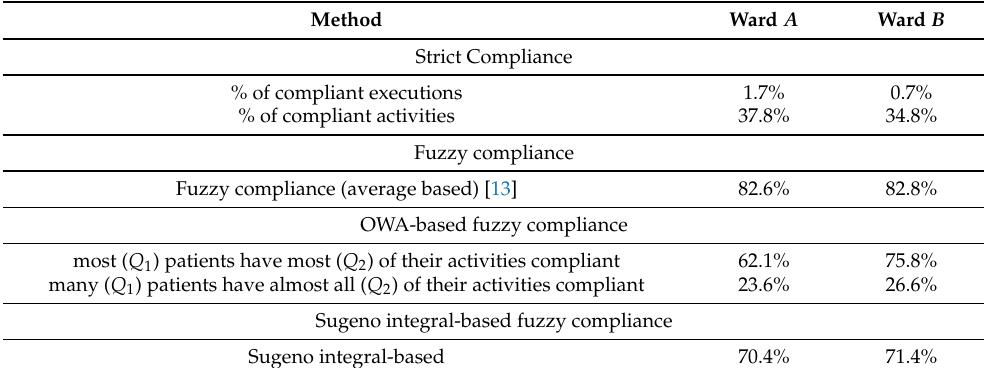
Table 4. Compliance values for Wards A and B according to different